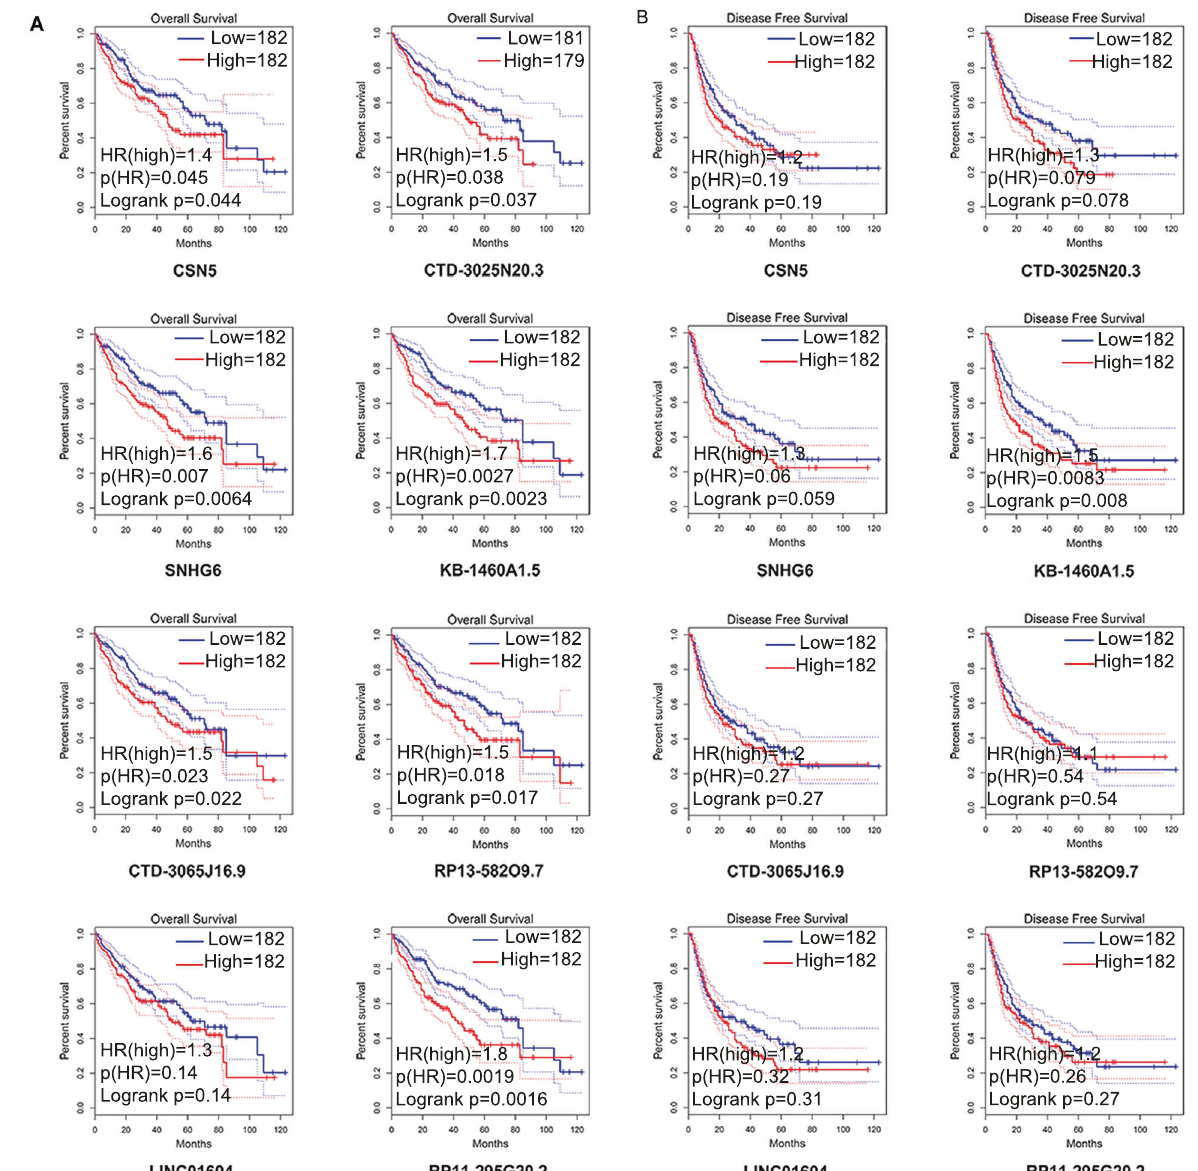
Fig. 3 The prognostic assessment of seven lncRNAs from TCGA. A Kaplan – Meier survival curve of overall survival (OS) for the seven lncRNAs (with 95% con fi dence interval). B Kaplan – Meier survival curve of disease-free survival (DFS) for the seven-lncRNA